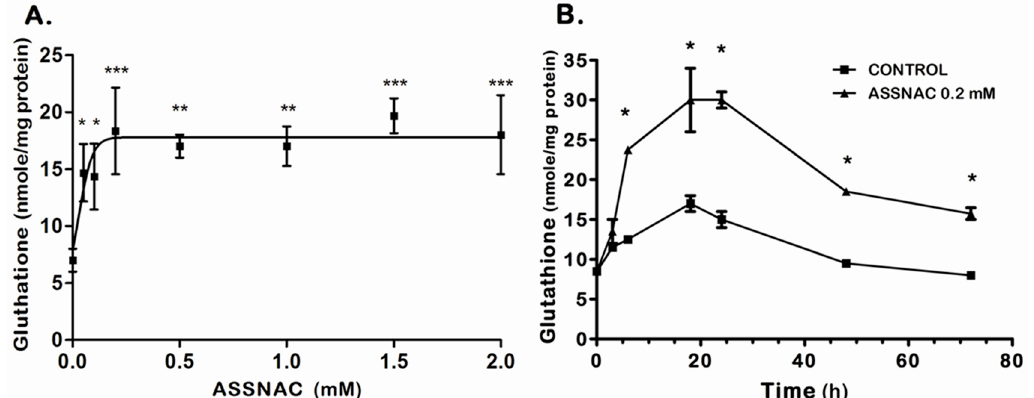
Figure 1. Effect of S -Allylmercapto- N -acetylcysteine (ASSNAC) on glutathione level in human retinal pigment epithelial (RPE) cells (line ARPE-19)—concentration and time titration. Confluent ARPE-19 cells were incubated in medium containing: ( A ) increasing concentrations of ASSNAC for 24 h, or ( B ) in the absence (control) or presence of ASSNAC (0.2 mM) for the indicated time periods and then glutathione was extracted and determined. Significant differences were marked: * p ≤ 0.05; ** p ≤ 0.01: and *** p ≤ 0.001.